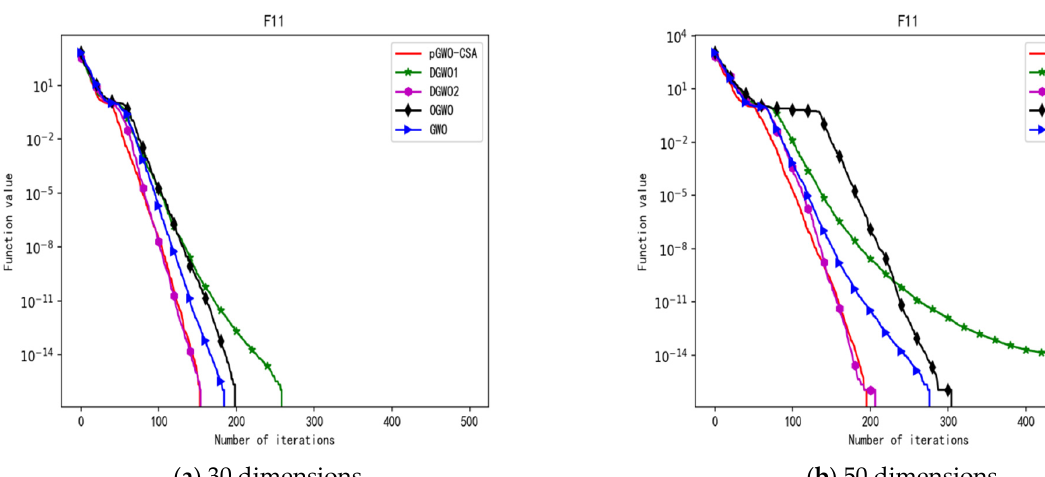
Figure 30. Convergence curve of test function F11.